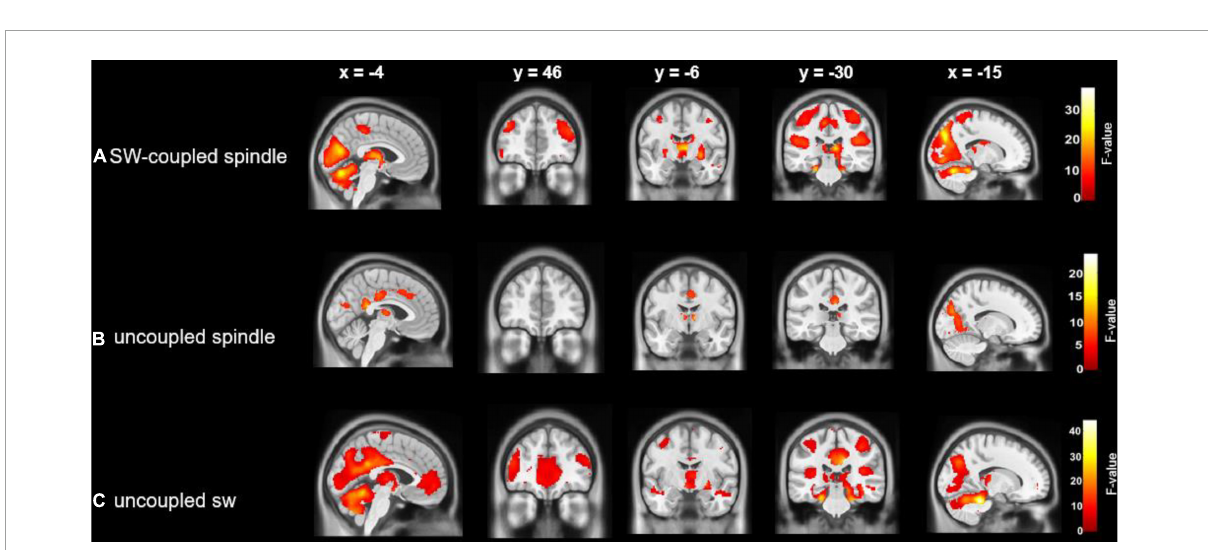
FIGURE3 Cerebral activations time-locked to: (A) SW-coupled spindles; (B) uncoupled spindles and (C) uncoupled slow waves. Statistical inferences were performed at p < 0.05, FWE corrected at the cluster level.